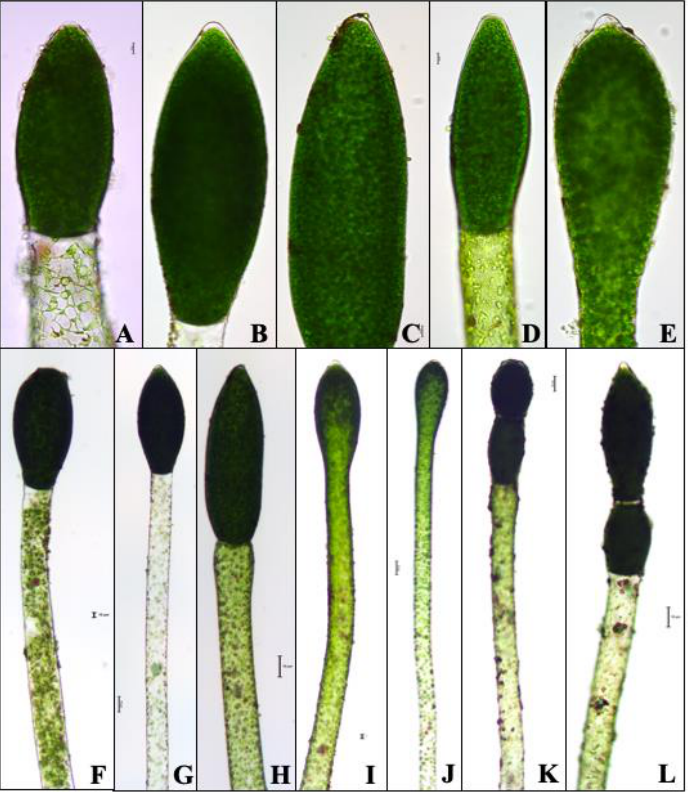
Figure 4. Terminal akinetes of Pithophora roettleri with variable shapes and sizes divided with or without a transversal, parting cell wall. ( A – E ) 400× magnification. ( F – L ) 100× magnification. ( A ) Net-like chloroplast, ( F ) present cell wall, ( J ) absent cell wall, ( K , L ) twin akinetes of the terminal cell. Scale bar = 10 µm.